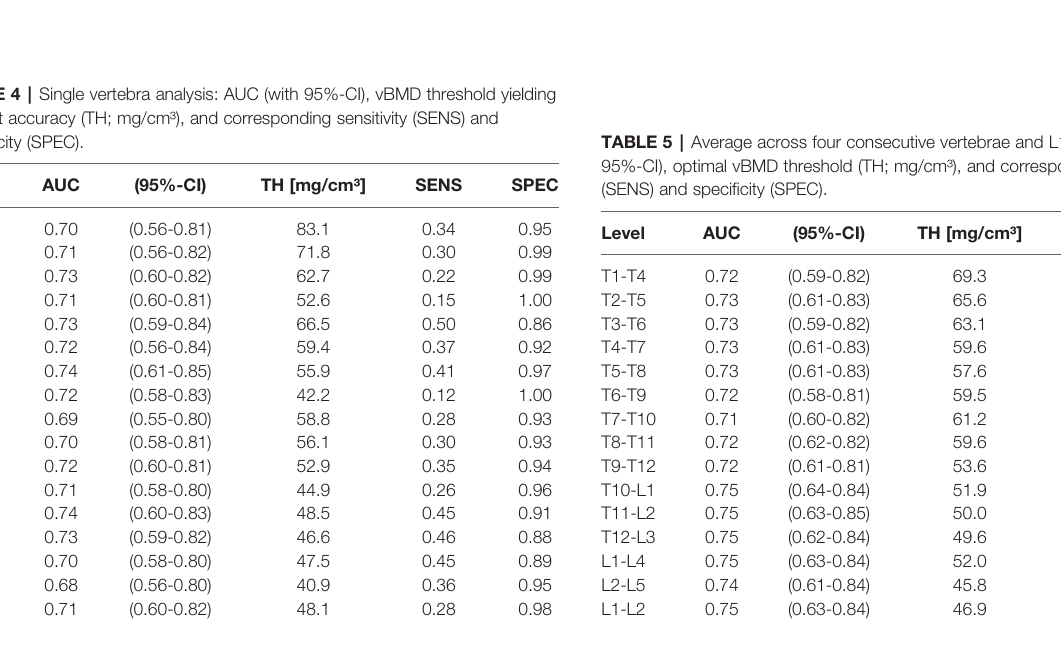
TABLE 3 | Odds ratios (OR) for the risk of incident VF, unadjusted as well as adjusted for age, sex and prevalent vertebral fracture. OR per SD vBMD decrease (95%-CI) Unadjusted Adjusted for age Adjusted for Adjusted for age, sex and prevalent VF age and sex vBMD T1-T4